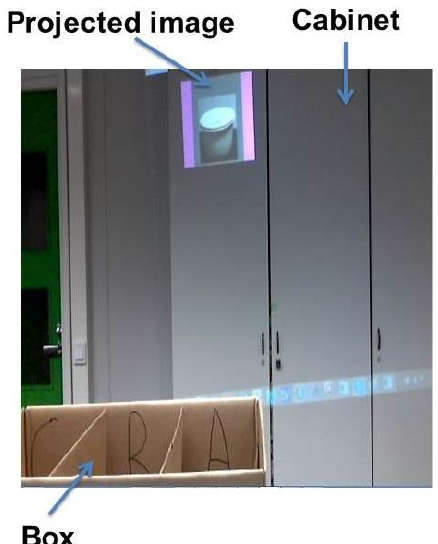
Figure 3 . A scene from the laboratory during the task